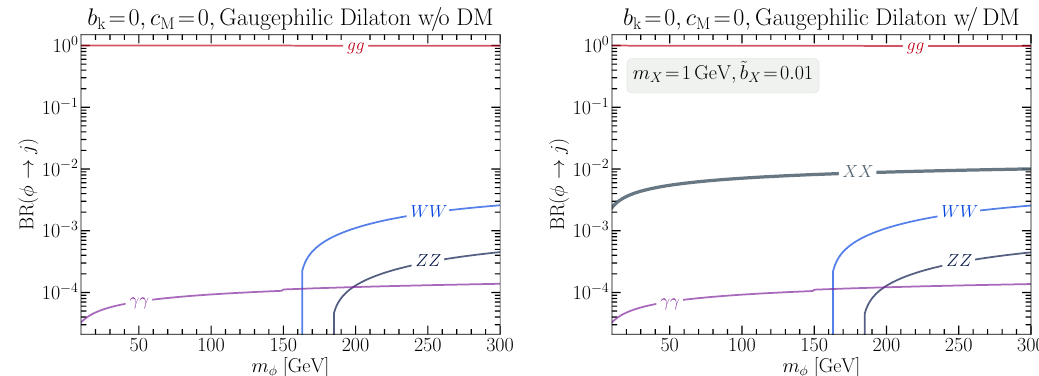
Figure 6 . Branching fractions of the dilaton in the gauge-philic dilaton scenario as a function of dilaton mass m (cid:30) for di(cid:11)erent choices regarding the vector DM. For the mass of dilaton above 2 m branching fractions are of the order ~ b = 0 : 01, the branching fraction to vector DM is about 1%. In the limit m x c = 0), the dilaton partial width to dark vectors is x